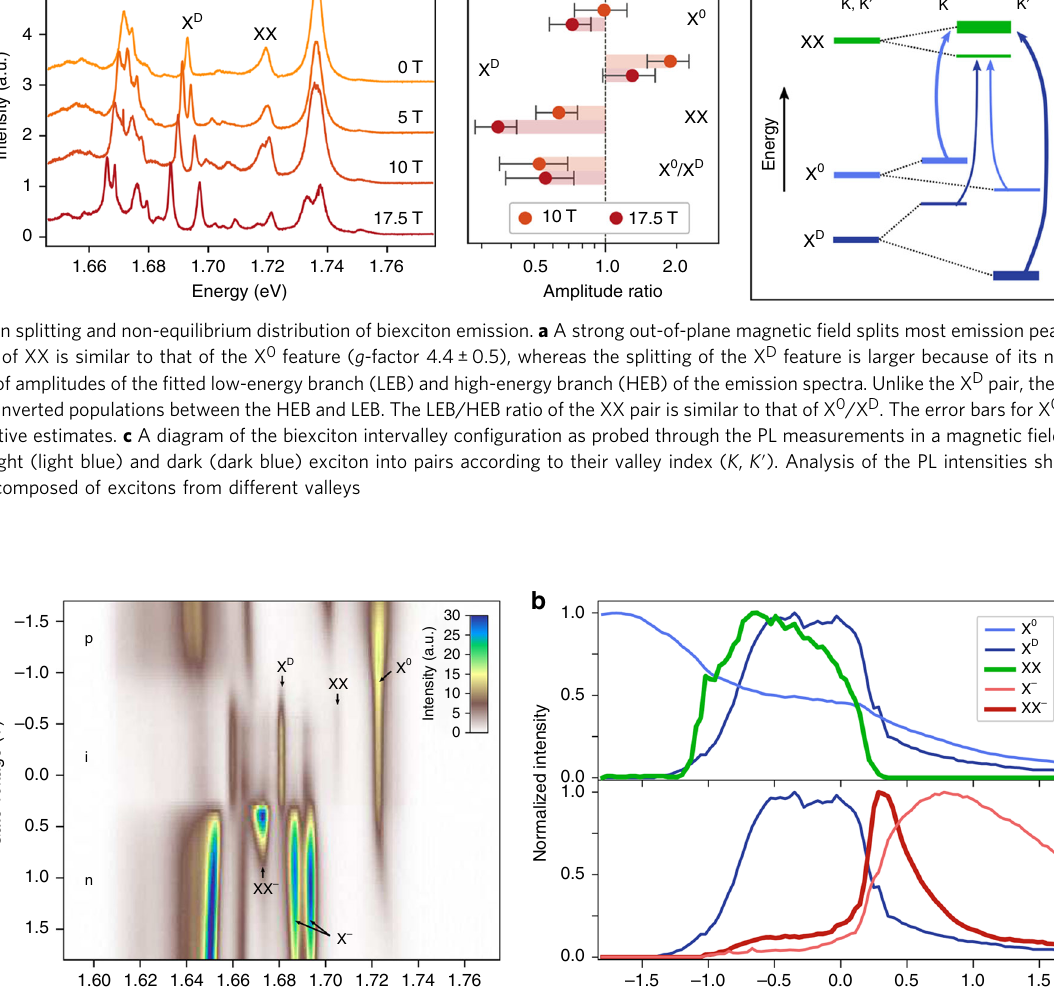
features can be resolved in the XX − peak at this stage. If no more than one electron/hole resides in any band, there should be two spin-valley con fi gurations for XX − . Due to the conduction band splitting, we expect the energetically favored con fi guration to be two holes in opposite valence band valleys, two electrons in opposite lower conduction band valleys and one electron in the higher conduction band. Because the valence band splitting is much larger — about 400 meV — no positively charged biexciton (XX + ) emission would be observed. Since the XX − peak appears most prominently at relatively low doping levels, we can rule out the possibility of it being related to a plasmon coupled exciton 23 . With respect to the two negatively charged trions, the XX − has a binding energy of 14 or 21 meV, in agreement with theoretical calculations 24 .